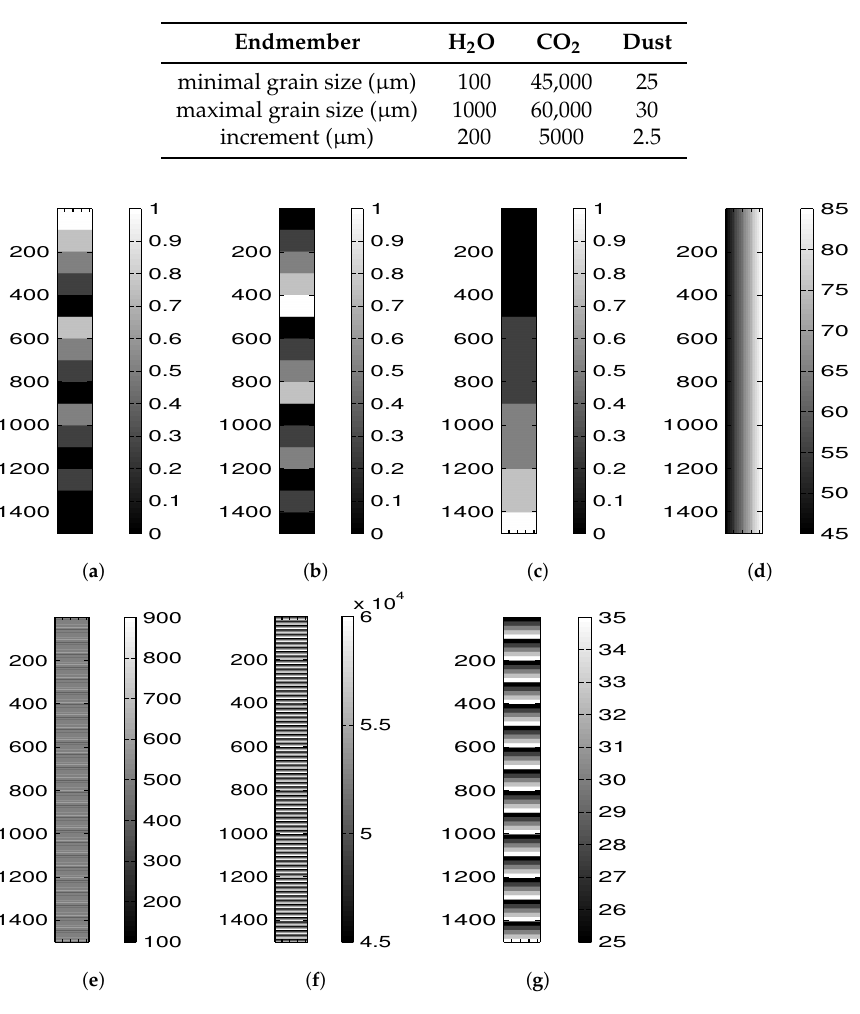
Table 4. Grain sizes of the three endmembers in the synthetic data.